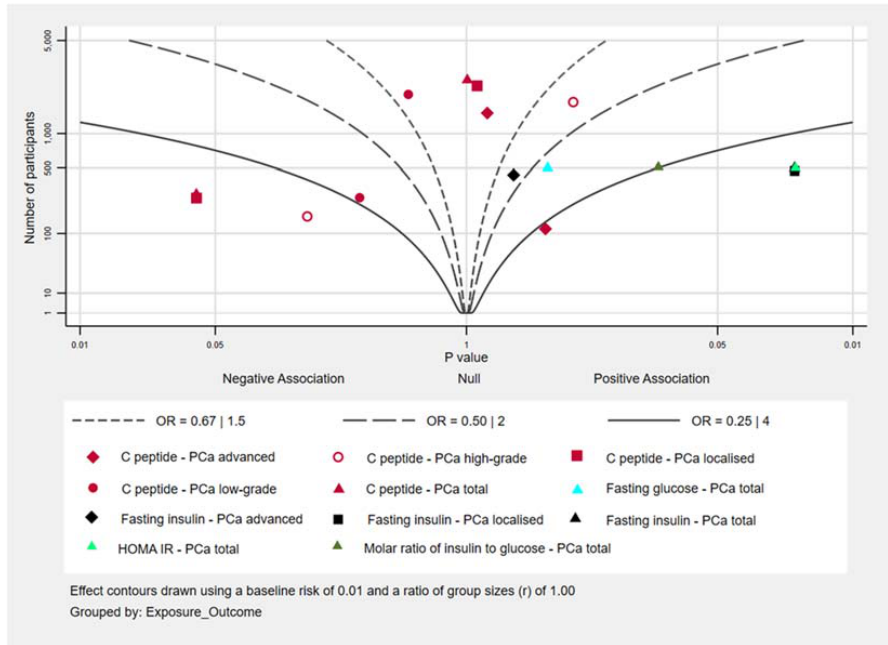
Figure 6. Albatross plot showing effect of insulin biomarkers on prostate cancer risk; each point on the figure represents a single analysis in an individual study. C ‐ Peptide